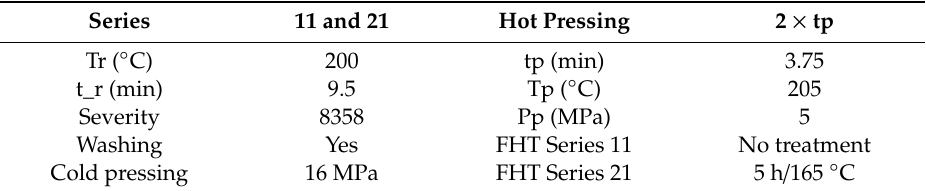
Table 1. Parameters for production of series 11 and 21 fiberboards.